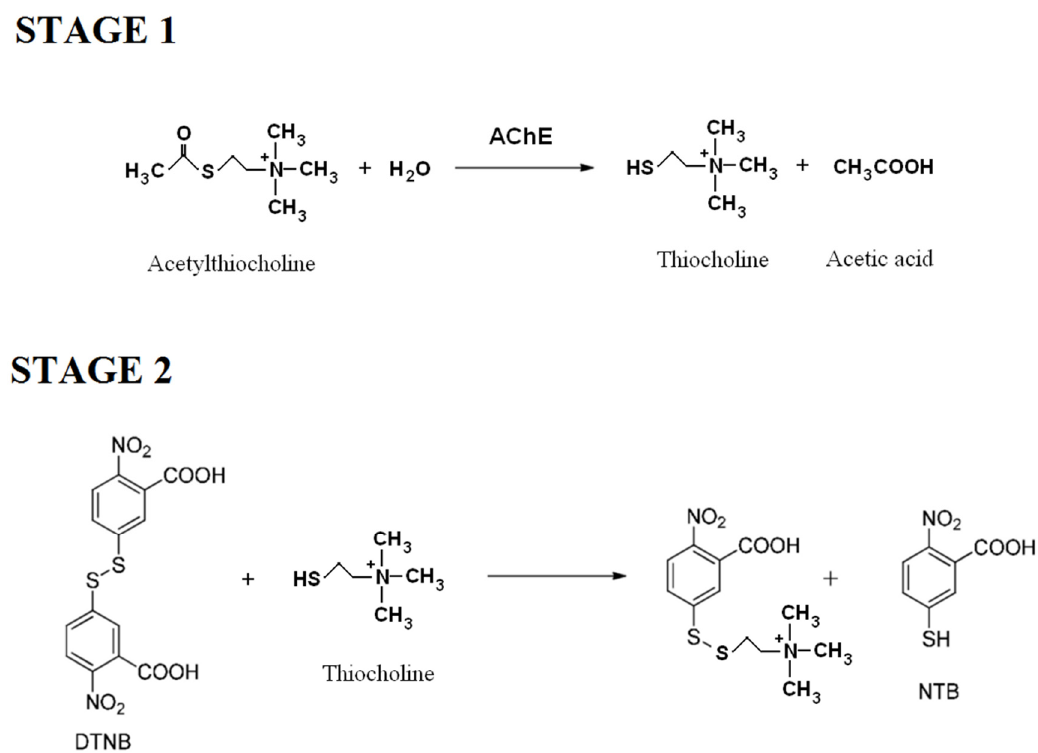
Figure 8. Reaction scheme for the determination of acetylcholinesterase activity.